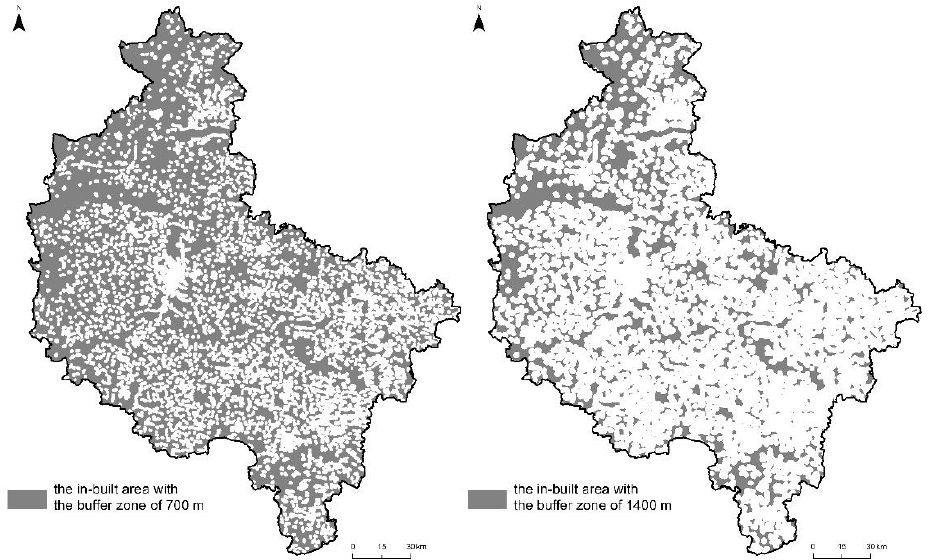
Figure 4. Area available for wind energy development—the built-up area with the buffer zones of 700 m and 1400 m in the Greater Poland Voivodeship (own calculations).